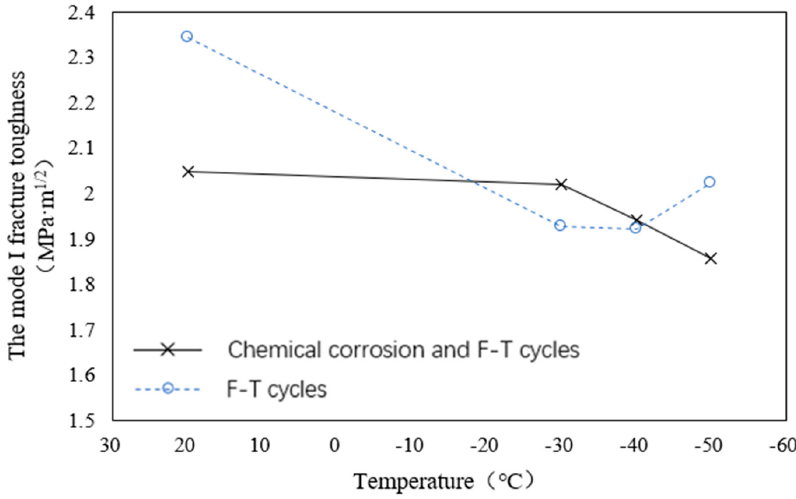
Figure 9. The K IC of tonalite specimens under freeze-thaw (G3) and the combined effect of chemical corrosion and freeze-thaw cycles (G4).